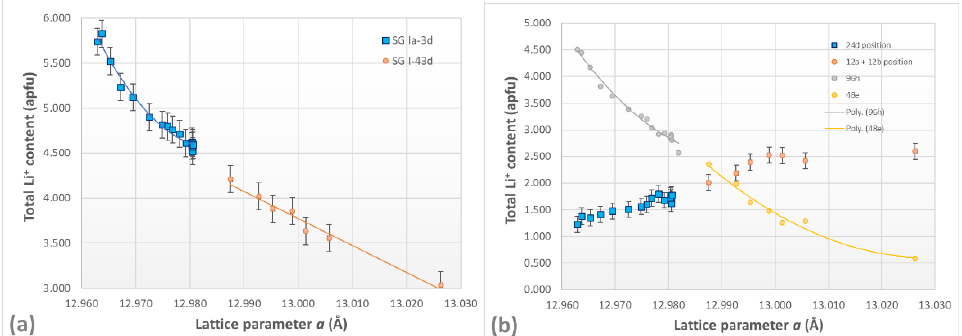
Figure 8. Variation of Li-site occupation in Al-stabilized LLZO garnets as a function of change in unit cell parameters during aging, from refinements of high-resolution X-ray diffraction data. ( a ) total Li content in the samples, ( b ) Li-content on the individual sites.